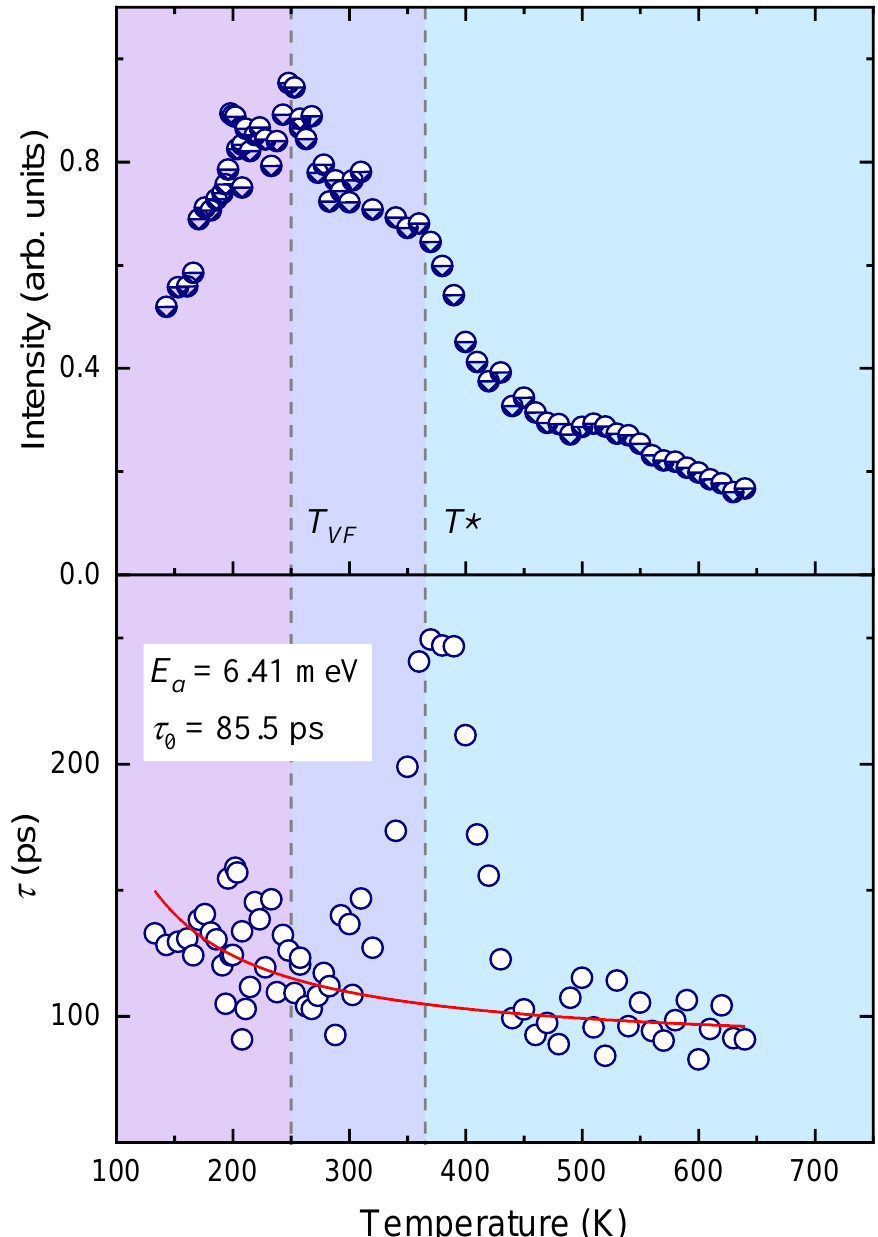
Figure 3. The temperature dependencies of intensity and relaxation time from the narrow QELS component in PMN. The circles are the results of calculations of experimental spectra with FSR = 12 GHz using Equations (1)–(4) (see text). The solid red line corresponds to the Arrhenius law. The colors in the figure highlight different temperature regions.